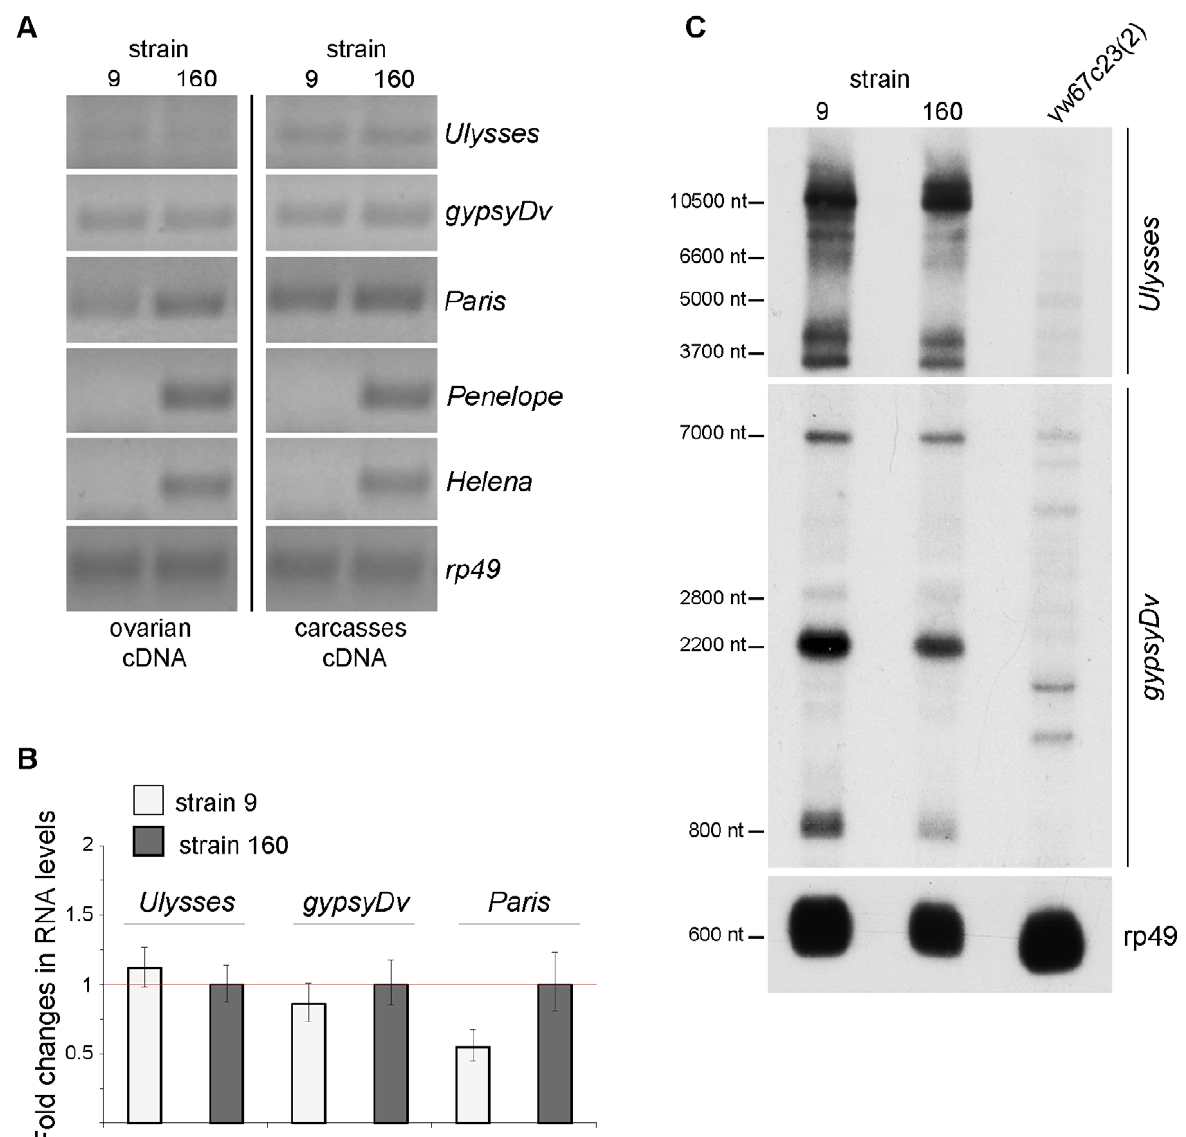
Figure 1. Transcription levels of selected D.virilis TEs. (A) semiquantitative RT-PCR data for ovaries and carcasses; (B) Quantitative RT-PCR analysis of TE transcription levels in ovaries. Since RT-PCR failed to reveal any transcription of Penelope and Helena in strain 9, we do not include the results of comparative analysis of these TEs by qRT-PCR in the panel; (C) Northern blot detection of Ulysses and gypsyDv sense transcripts in strains 9 and 160. Poly-A RNAs isolated from strain 9, strain 160 and D. melanogaster yw 67c23 strain ovaries were used. The size of marker RNA is given in nt at the right. The filter was rehybridized with a fragment of constitutively expressed D. melanogaster rp49 to monitor the level of loaded RNA.